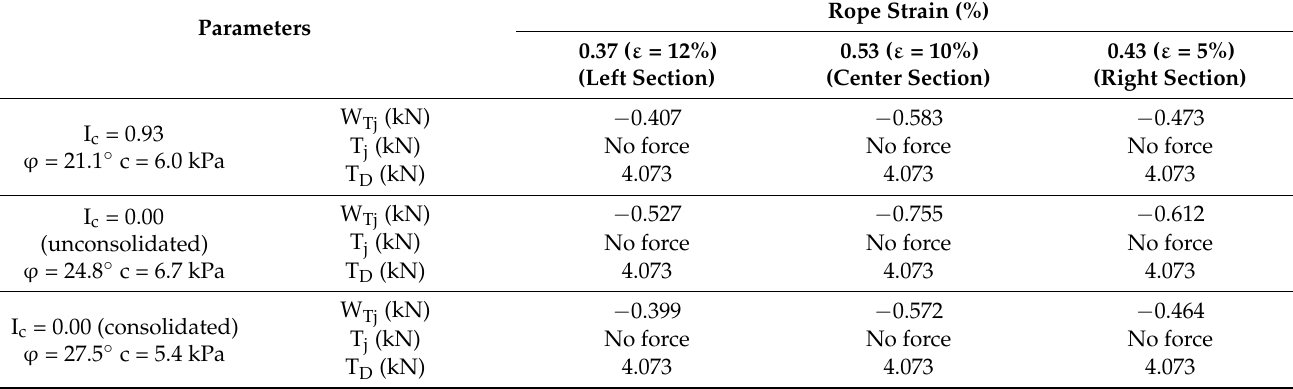
Table 7. Design tension force in the ropes placed on the slope part of an inclination of 1:1.8 in comparison to the rope design. Tension strength (location